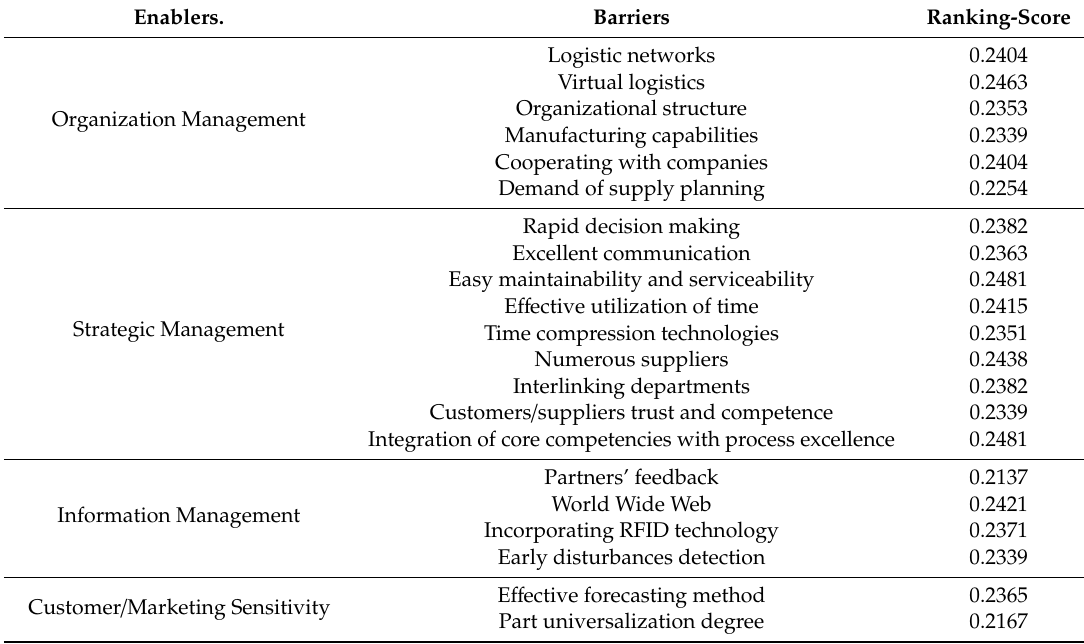
Table 4. The supply chain agility enablers, barriers to foster sustainability, and corresponding ranking score.